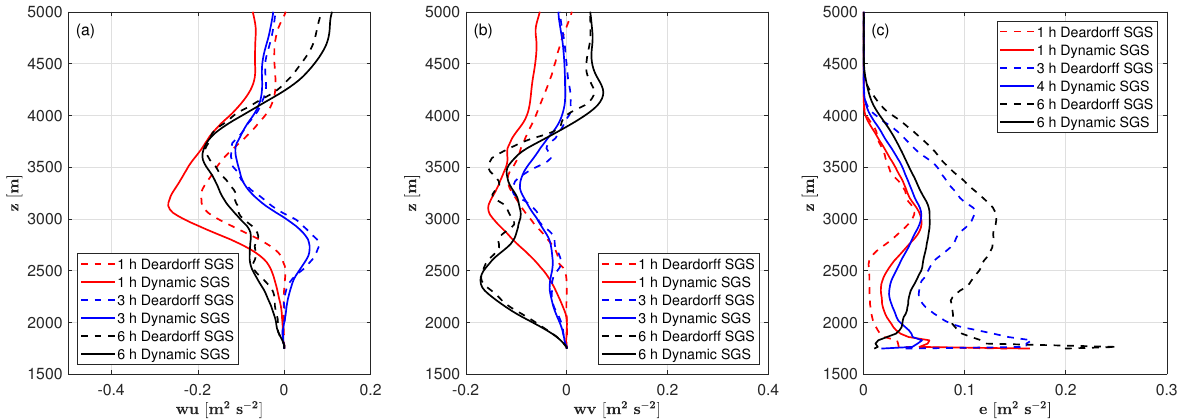
Figure 9. Horizontal mean vertical profiles of ( a ) flux component wu , ( b ) flux component v and ( c ) subgrid-scale (SGS) turbulent kinetic energy e at the whole domain in time after the start of the simulation at 06:00 UTC. The dashed curves indicate the simulated values by using Deardorff SGS model. The continuous curves present the simulated values by using the dynamic SGS